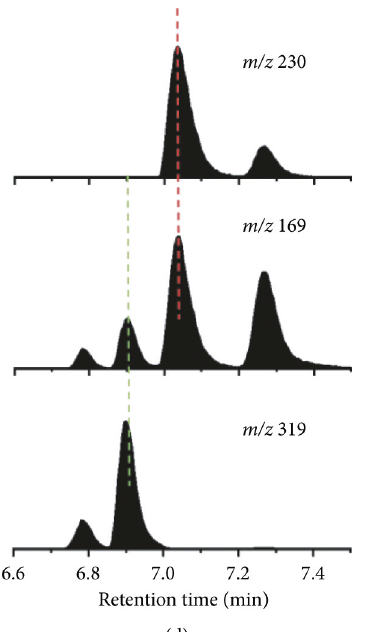
Figure 2: Mass spectra of chromatographic peaks A2 (a) and M2 (b) presented in Figure 1; Chromatographs of typical fragment ions of peak A2 (c), and peak M2 and M3 (d) reflecting the compositions of two PFHxS